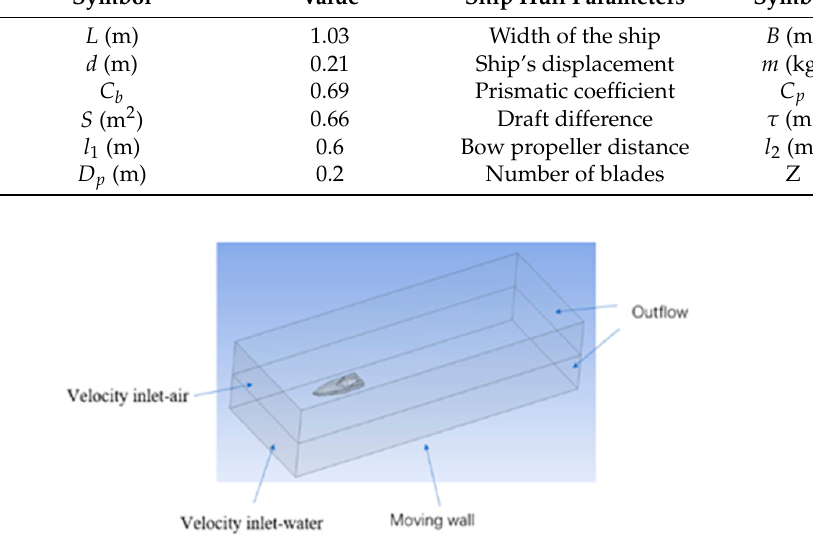
Figure 2. Schematic diagram of the computational domain. Table 1. Unmanned ship hull parameter.